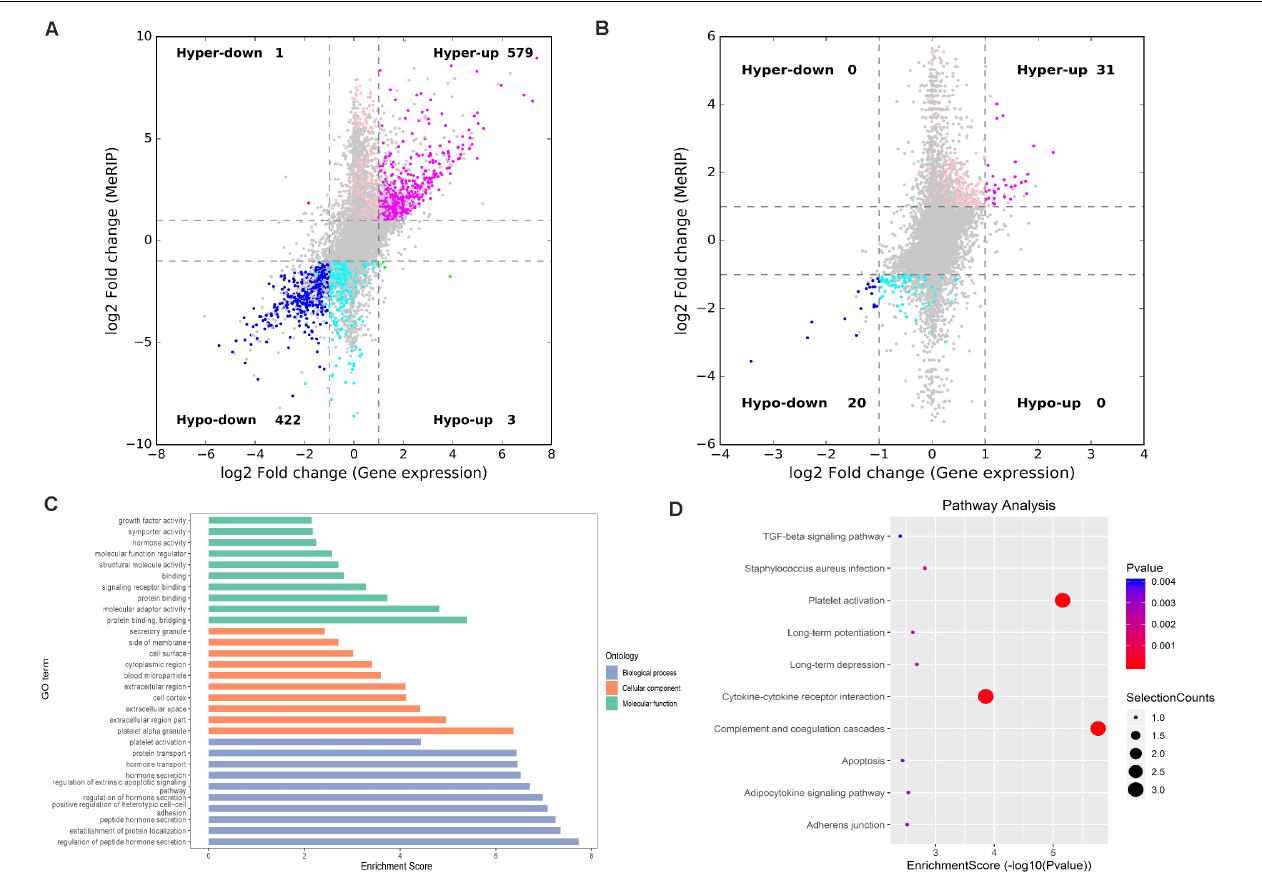
FIGURE 7 | Conjoint analysis of differentially methylated genes and differentially expressed genes. (A) Four-quadrant graph exhibiting the DEGs containing differentially methylated m6A peaks in IvC. (B) Four-quadrant graph exhibiting the DEGs containing differentially methylated m6A peaks in TvI. (C) Major gene ontology terms were significantly enriched for the genes containing m6A sites with reverse methylation and expression trends between IvC and TvI. (D) Major enriched pathways for the genes containing m6A sites with reverse methylation and expression trends between IvC and